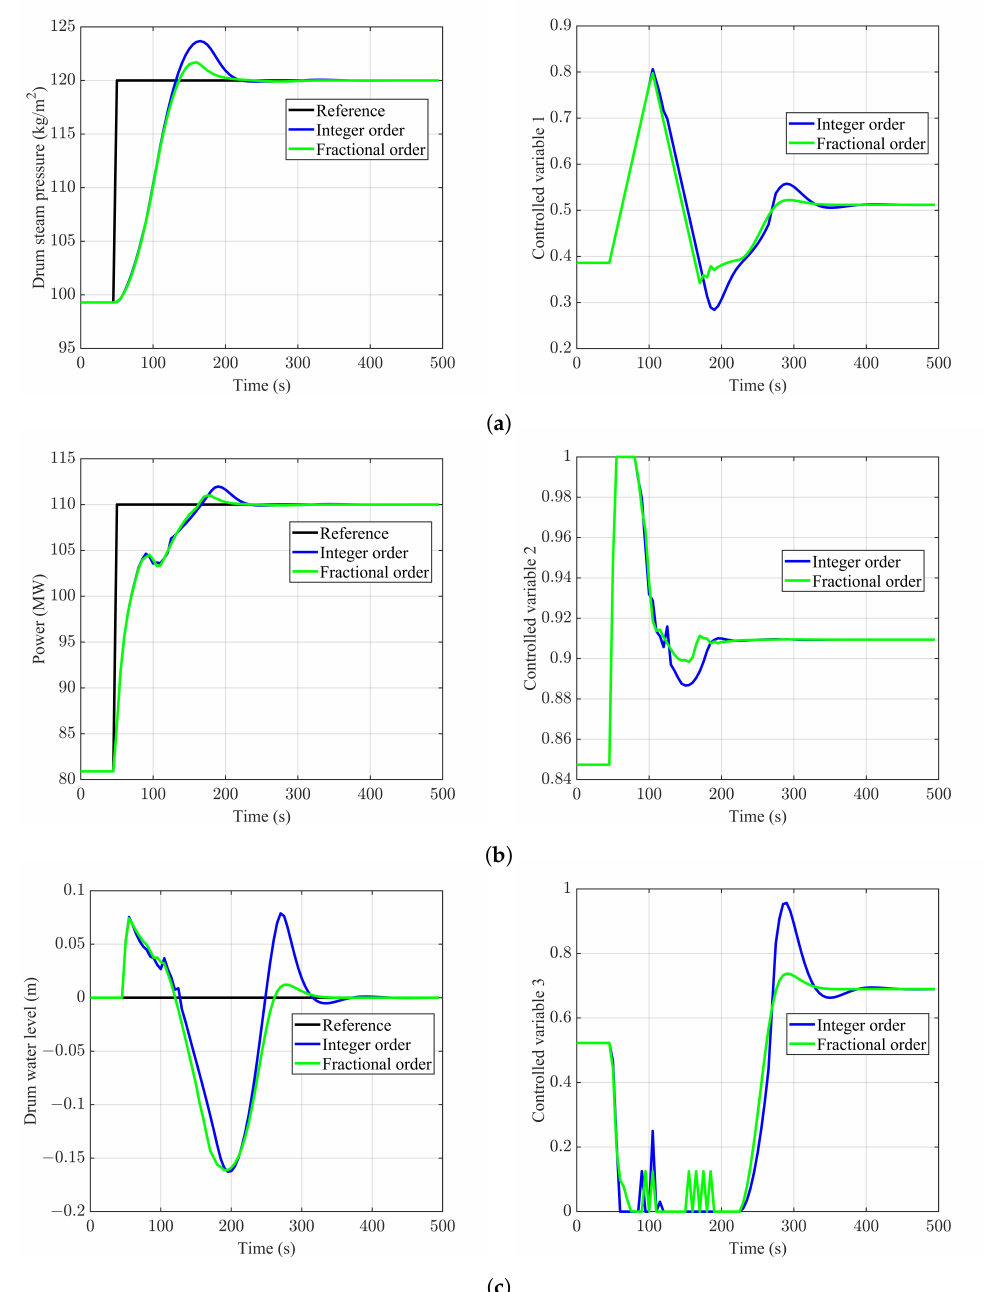
Figure 6. Outputs and inputs of the boiler-turbine system with FOMPC and MPC in the reference tracking experiment (the outputs are listed on the left hand, and the inputs are listed on the right hand). ( a ) control loop for drum steam pressure, ( b ) control loop for required power, ( c ) control loop for drum water